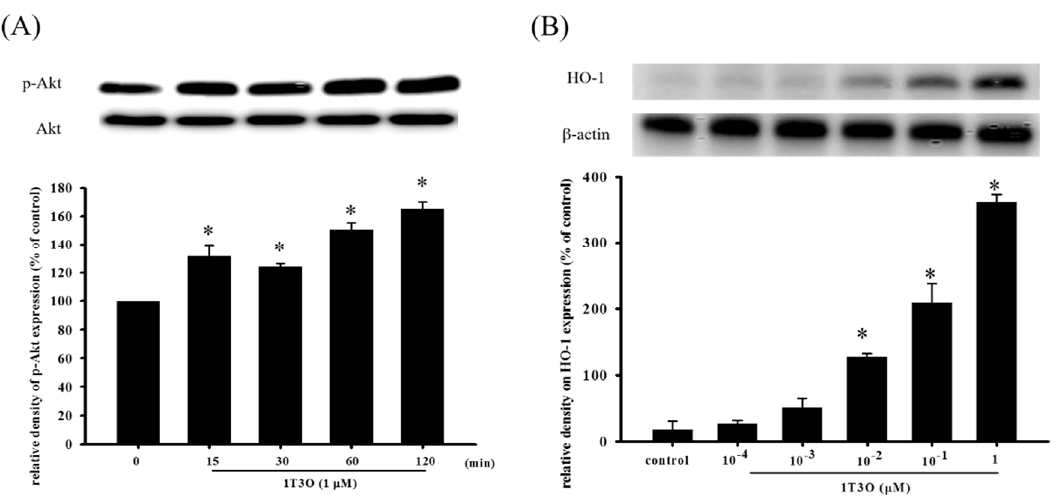
Figure 7. The effect of 1T3O on phospho-Akt and heme oxygenase-1 (HO-1) protein levels in SH-SY5Y cells. Western blot was used to quantitate phospho-Akt and HO-1 protein levels and the effect of 1T3O (1 µ M) on Akt phosphorylation at different time points ( A ) and the effect of different 1T3O concentrations (1, 10 − 1 , 10 − 2 , 10 − 3 , and 10 − 4 µ M) on HO-1 protein level ( B ) were studied. 1T3O significantly increased the protein expression of phospho-Akt and HO-1. Data are presented as mean ± SEM. * p < 0.05 vs. Control.